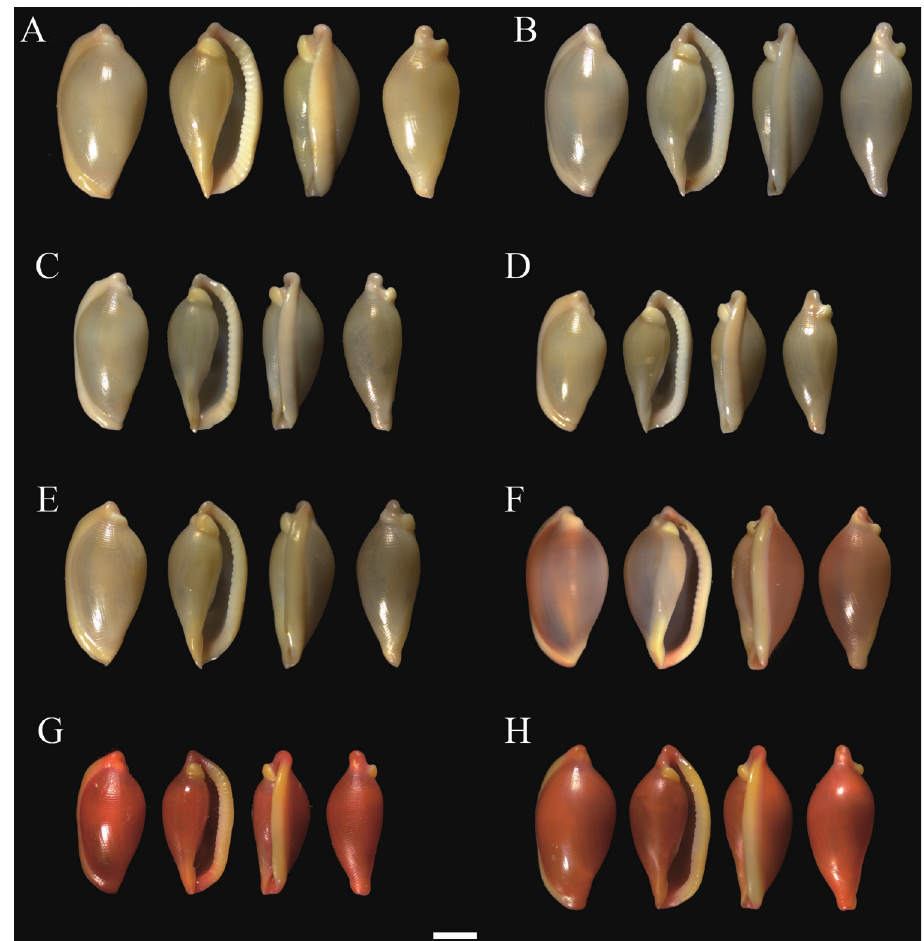
Figure 3. Dorsal, ventral, and lateral views of shells of Sandalia A S. bridgesi Lorenz, 2009